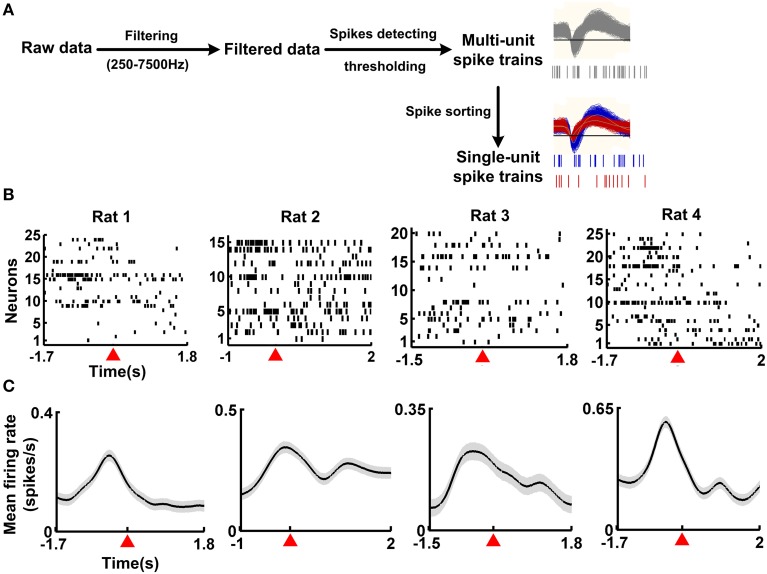
Single-unit activity from four example correct trials during the working memory task. (A) Spike detection and sorting from the recordings. The raw data was filtered (250–7500 Hz) and multi-unit spikes were detected using a preset threshold. Then, single-unit spike trains were isolated from the multi-unit spikes. (B) Raster plots of neuronal activity during the working memory task for 4 rats. For each rat, one correct trial was shown. Each row plotted the response of an individual neuron. Time 0 represented the reference point, marked by the red triangle. (C) Mean firing rates of neuronal population during the working memory task. Data from (B) were used, with 10 correct trials for each rat. Shaded areas indicated the SEM. Time 0 represents the reference point, marked by the red triangle.